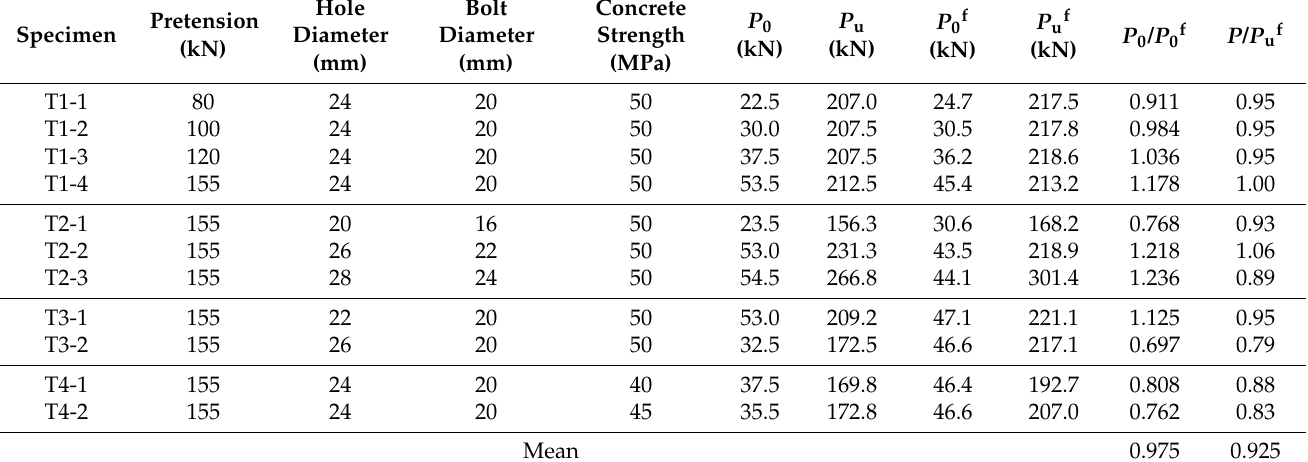
Table 2. Comparison of the ultimate shear capacity obtained from test [19] and finite element (FE) results (per bolt). Pretension Specimen